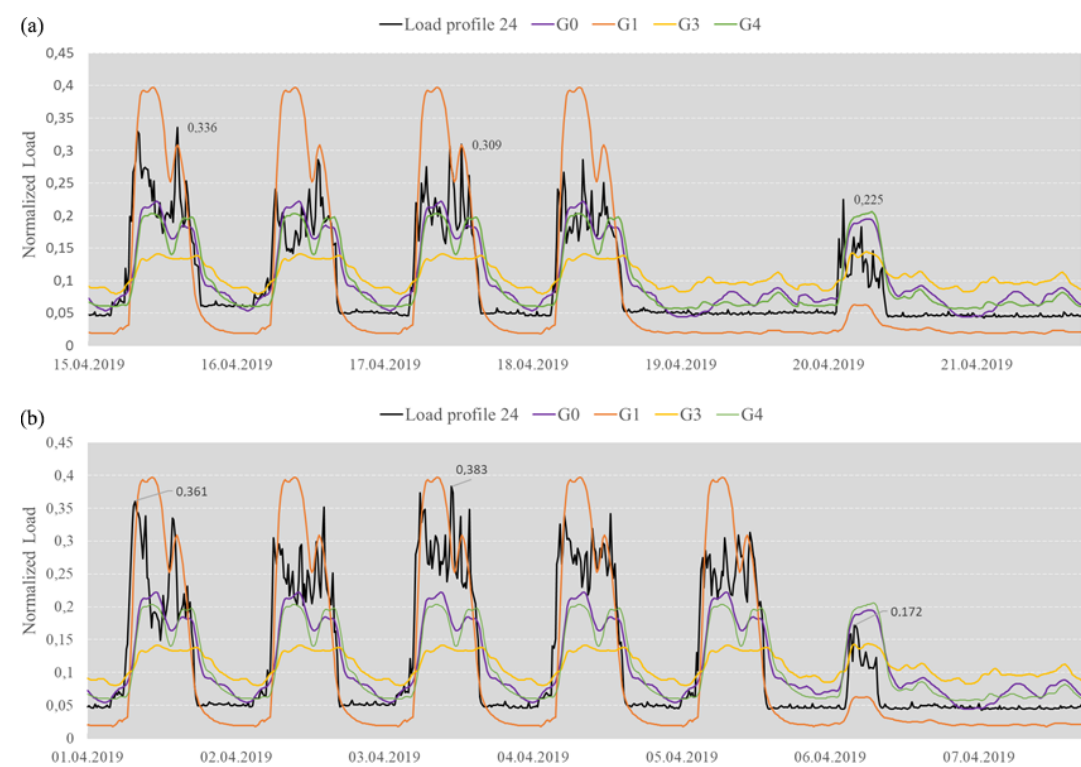
Figure 3. Measured load compared to standard load profiles on weekdays (a) and public holidays (b) .